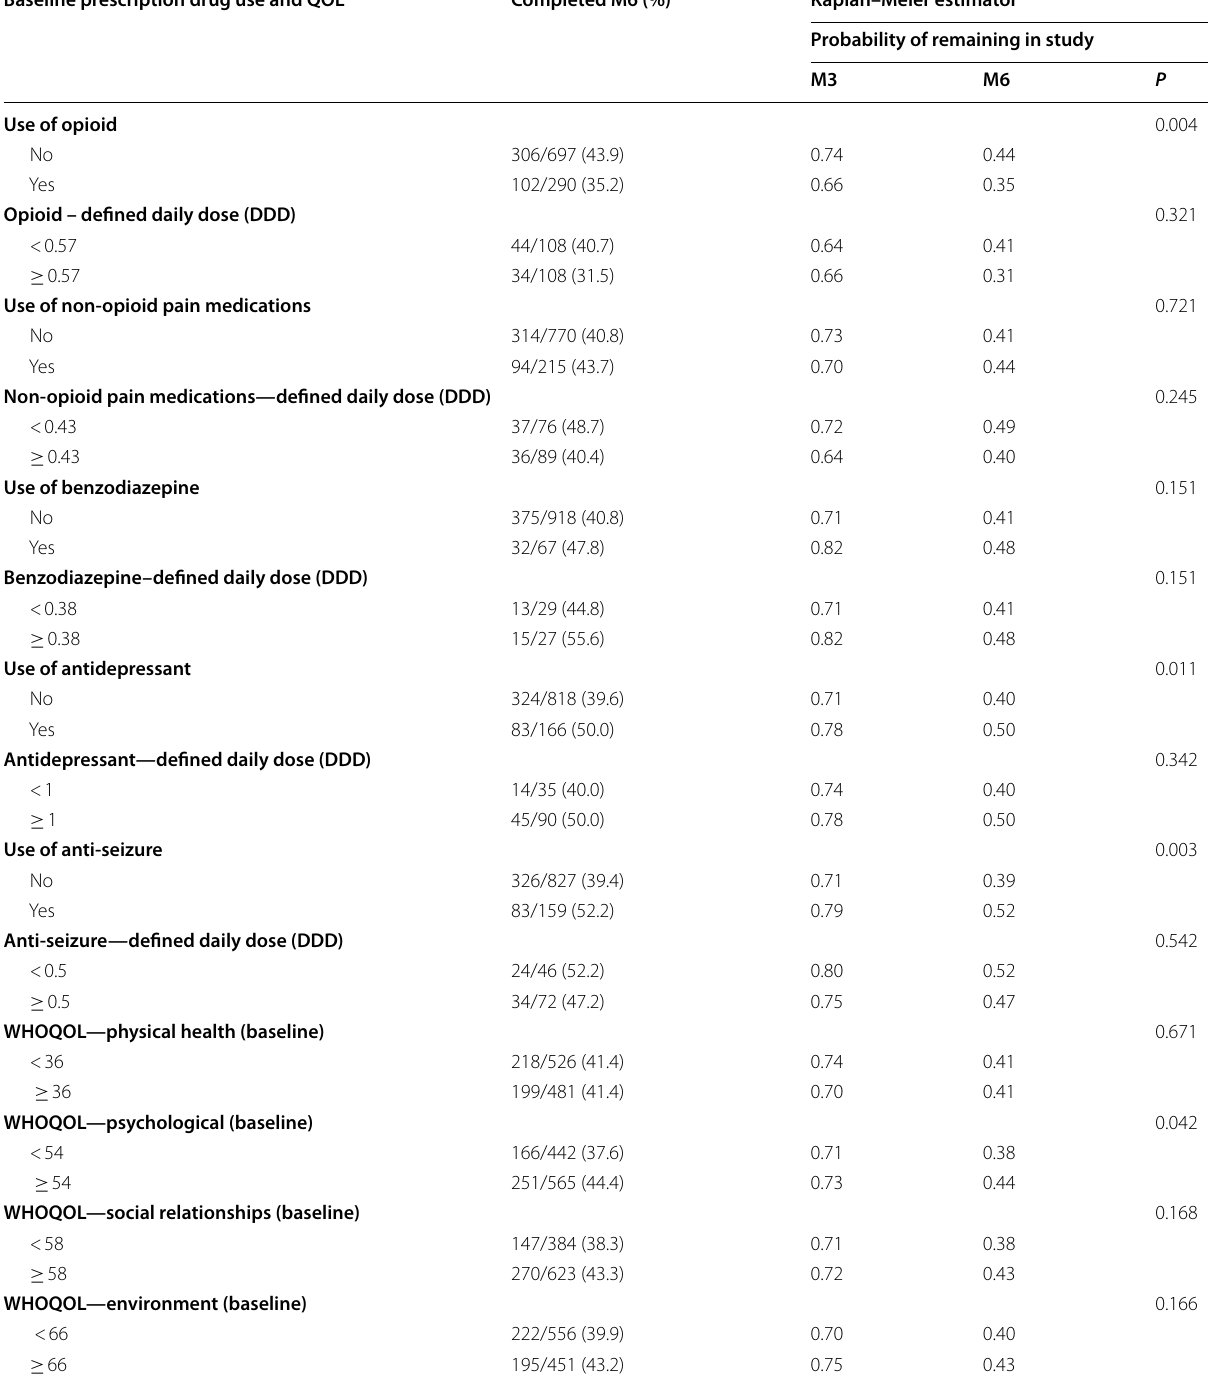
Table 2 Percent completing M6 and probability of retention at M3 and M6 by baseline prescription drug use and quality of life